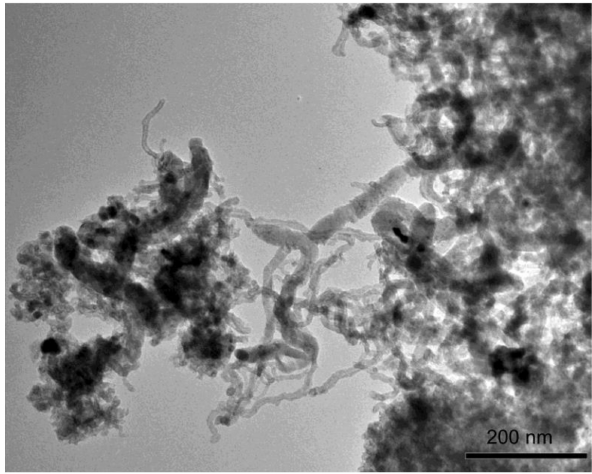
Figure 14. TEM images of spent NiMoCo/GDC catalyst at different